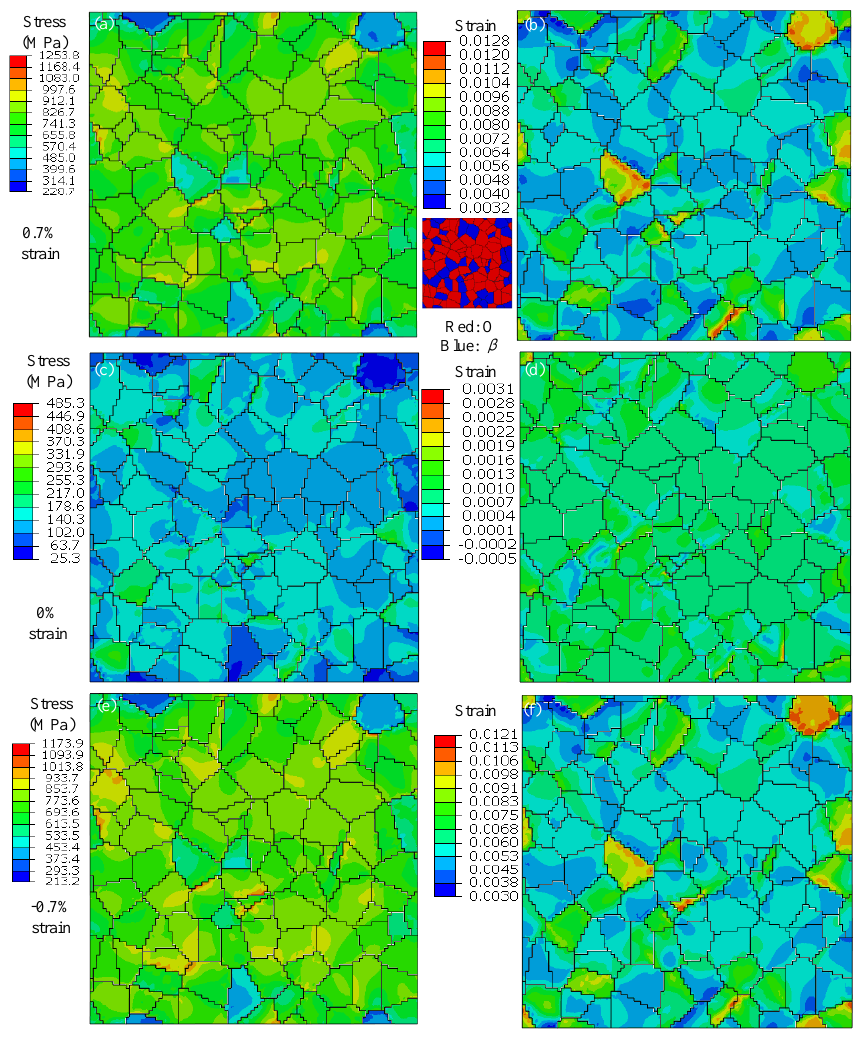
Figure 9. Stress and strain distribution figures of three loading points: ( a , b ) 0.7% strain; ( c , d ) 0% strain; ( e , f ) − 0.7% strain. (The O and β phases are also shown in figure, as same as Figure 6a). According to the discussion of strain and stress distribution, it was found that phase boundaries are the most important positions relating to stress concentration. Figure 10 shows the rotation angle and stress at 0.7% strain. The rotation angle distribution of each grain is shown in Figure 10a, the stress distribution is shown in Figure 10b. Due to the total strain range at 1.4%, the rotation angles of each grain during fatigue loading are 0.22~0.62 ◦ . Although the grain rotation is not significant, the grain rotation angle between the two phases is obviously compared, and the grain rotation has a strong correlation with the stress concentration. The rotation angle is closely related to the phase, and most of the grains with a rotation angle larger than 0.4 ◦ are β phase, and most of them are stress concertation positions, as shown in Figure 10b (circled by solid and dotted lines). The dotted line circles show the position of stress concentration at the grain with large rotation angle, and the solid line circles show the position of no stress concentration at the grain with a large rotation angle. The dotted line circles all are O/ β phase boundary, and the solid line circles are all same phase boundary. The plastic deformation ability of the two phases is different; during fatigue loading, β phase is more prone to plastic deformation and grain rotation is more significant. The strain incompatibility between the two phases is more serious, which makes the O/B boundary prone to stress concentration.